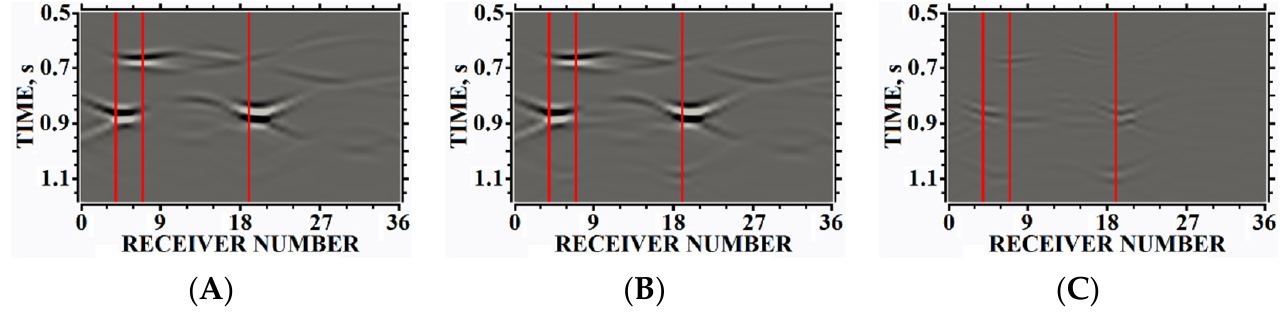
Figure 10. Seismograms, X-component of the anomalous velocity: ( A ) with an overlapping curvi- linear mesh; ( B ) without an overlapping curvilinear mesh; ( C ) difference. The testing performed demonstrates the high accuracy of the proposed numerical method. We specifically used such a discretization from 17 to 25 points (in dependence on the inclination between the wavefront and the coordinate axis) of the background computa- tional mesh are used to treat the P-waves, and from 10 to 15 points are used to treat the S- waves. This allows for a more representative comparison of the proposed method with available alternatives, including the one presented in [22].